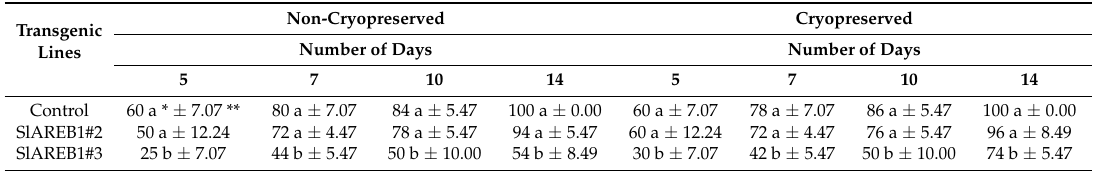
Figure 8. Regrowth of two transgenic lines overexpressing SlAREB1 (SlAREB1#2 and SlAREB1#3) and negative control (-ve control) after V-cryoplates treatment of 3 day incubation in 0.3 M sucrose and cold acclimatization for 4 days with (+LN) or without liquid nitrogen ( − LN). Table 4. Germination percentages of non-cryopreserved and cryopreserved seeds of negative control, SlAREB1#2, SlAREB1#3 transgenic tomato plants. Transgenic Lines